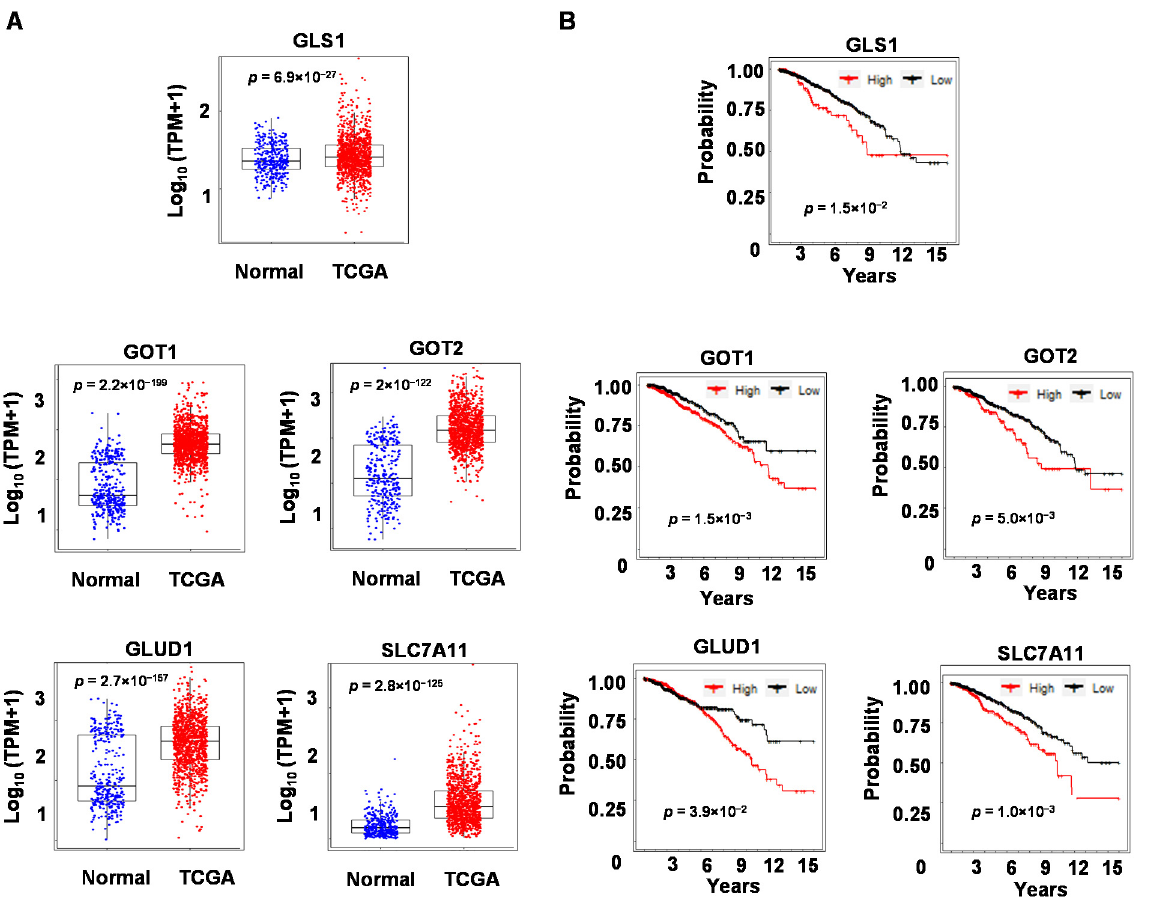
Figure 6. Glutaminolysis genes are upregulated in breast cancer patient samples and associated with lower survival. ( A ) Expression of genes in the glutaminolysis pathway was compared between GTEx normal breast tissue and patients in the TCGA-BRCA cohort using Welch’s two-sample t -test. ( B ) Survival analysis of patients with high vs. low expression of these genes was conducted, and the log-rank p -values are reported.